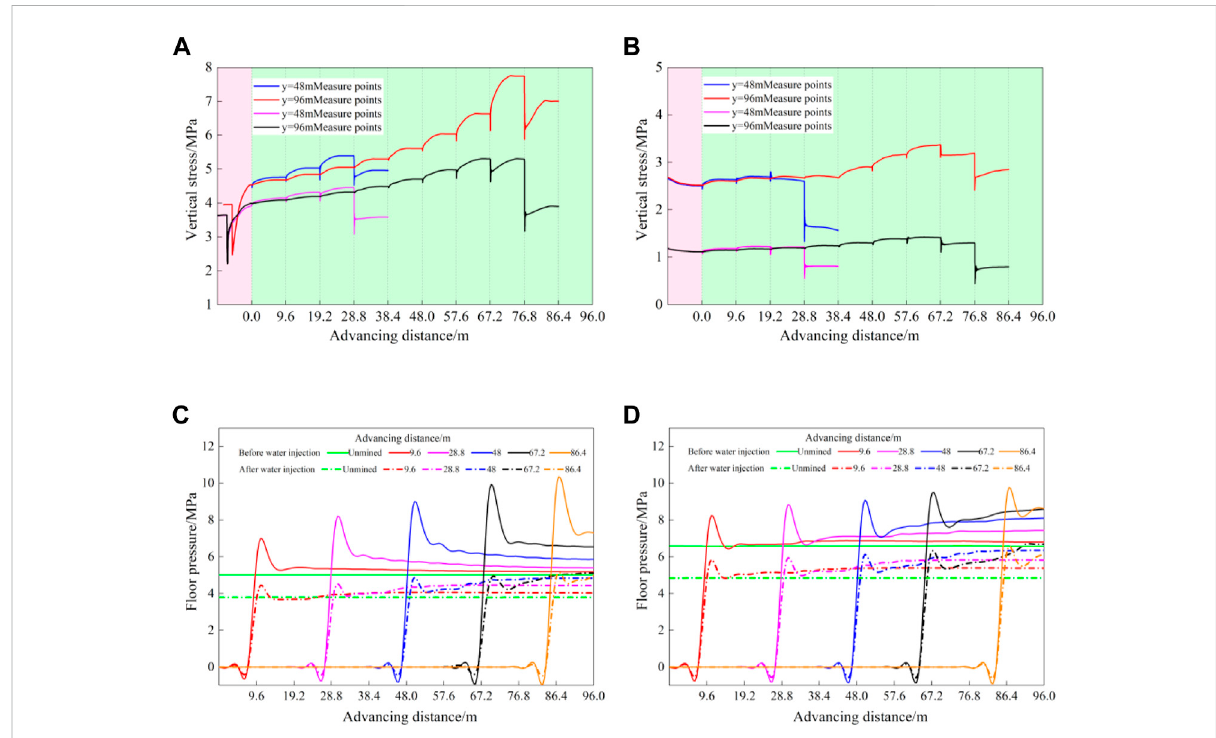
FIGURE 10 Stress evolution law of the internal measurement point of the 45# and 43# top coal and the fl oor. (A) Stress evolution law of 45# top coal. (B) Stress evolution law of 43# top coal. (C) Stress evolution law of 45# fl oor. (D) Stress evolution law of 43# fl